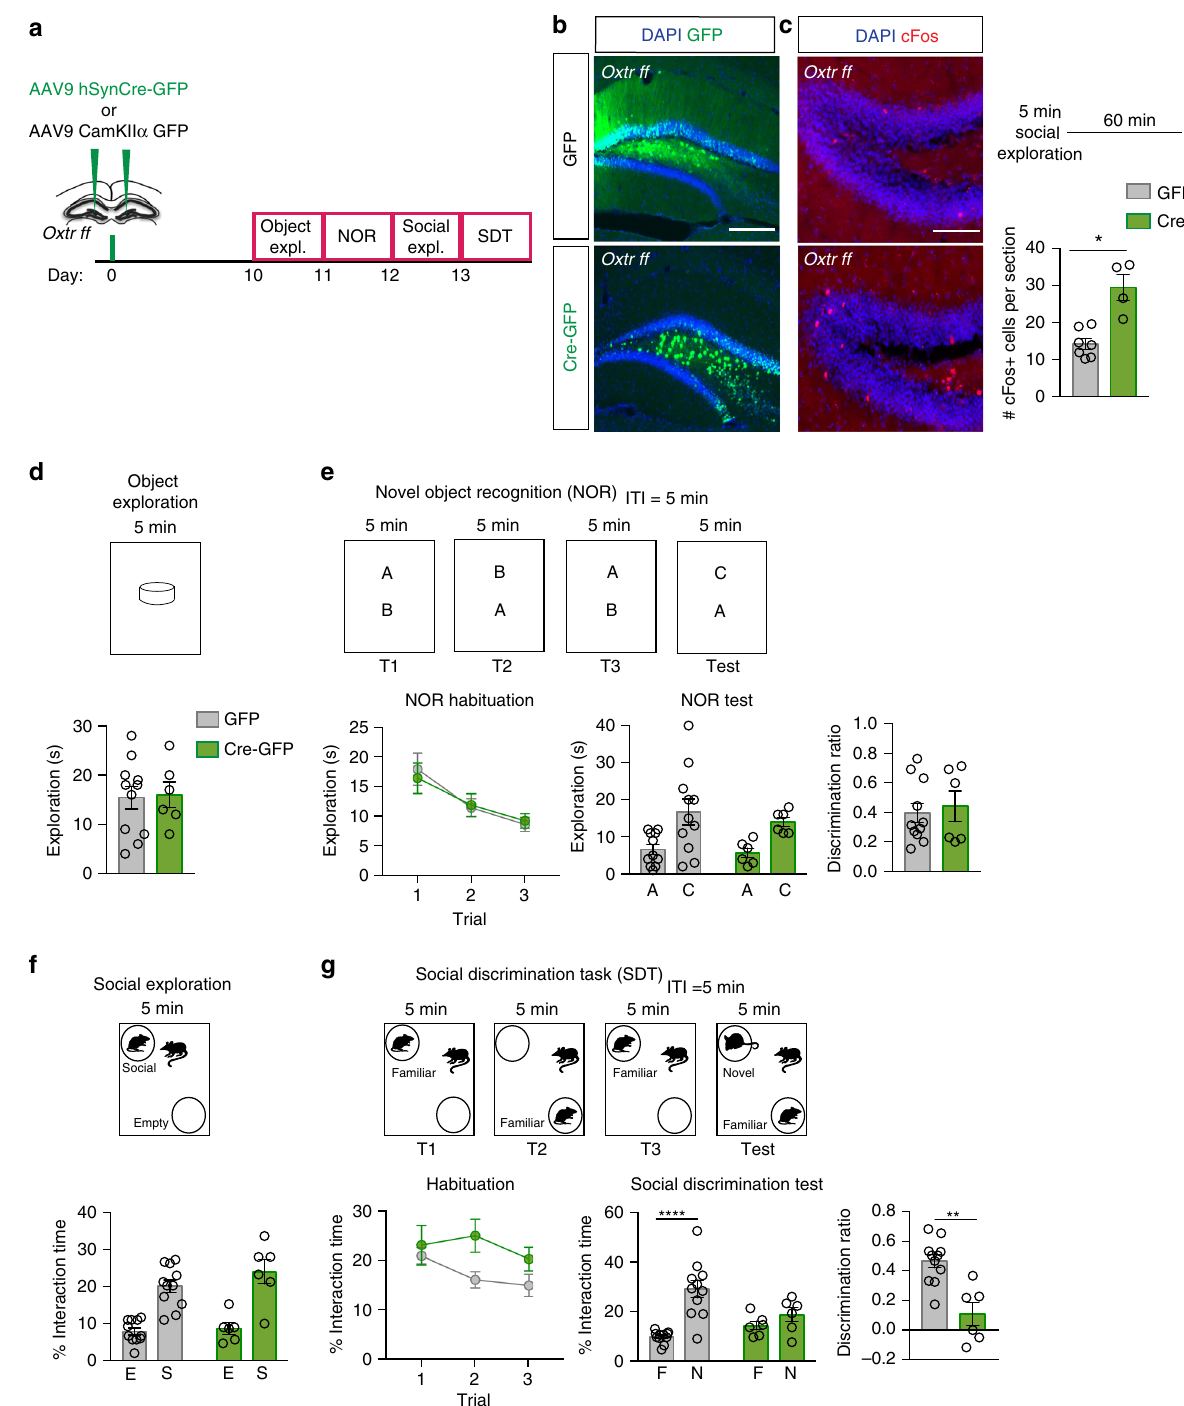
Fig. 2 Viral recombination of Oxtr in anterior DG hilar neurons impairs discrimination of social, but not non-social, stimuli. a Schematic illustrating viral injection and behavioral testing timeline. b Representative images of Cre and GFP virus infection in aDG. Scale bar, 200 μ m. c Representative images and quanti fi cations of cFos immunoreactivity in granule cell layer of aDG (GFP: n = 7, Cre: n = 4). Scale bar, 75 μ m. d Behavioral schematic (top) and quanti fi cation (bottom) of single object exploration (GFP: n = 11, Cre: n = 6). e Behavioral schematic (top) and quanti fi cation (bottom) of novel objection recognition (GFP: n = 11, Cre: n = 6). Quanti fi cations are displayed as Habituation (trials 1 – 3), Test (trial 4), and discrimination ratio (trial 4). f Behavioral schematic (top) and quanti fi cation (bottom) of social exploration test (GFP: n = 11, Cre: n = 6). g Behavioral schematic (top) and quanti fi cation (bottom) of social discrimination task (GFP: n = 11, Cre: n = 6). Quanti fi cations are displayed as Habituation (trials 1 – 3), Test (trial 4), and discrimination ratio (trial 4). All data are displayed as mean ± SEM